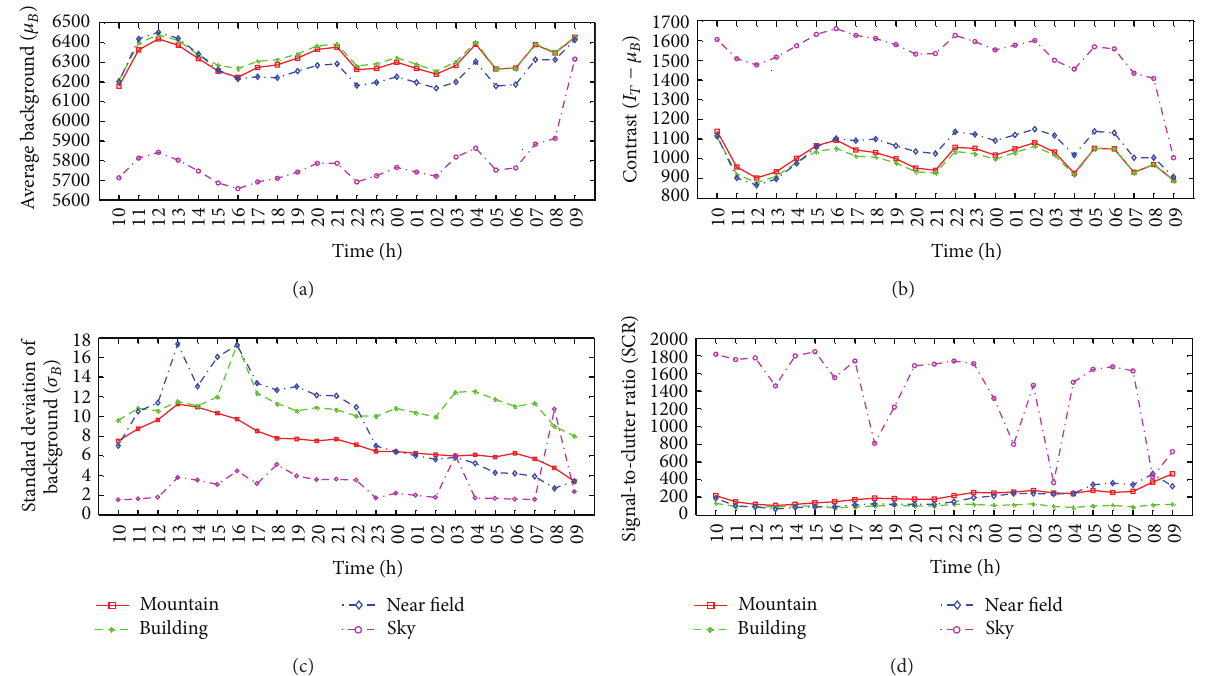
Figure 12: Variation analysis of winter according to the recording time: (a) average background versus time, (b) contrast versus time, (c) standard deviation versus time, and (d) SCR versus time.